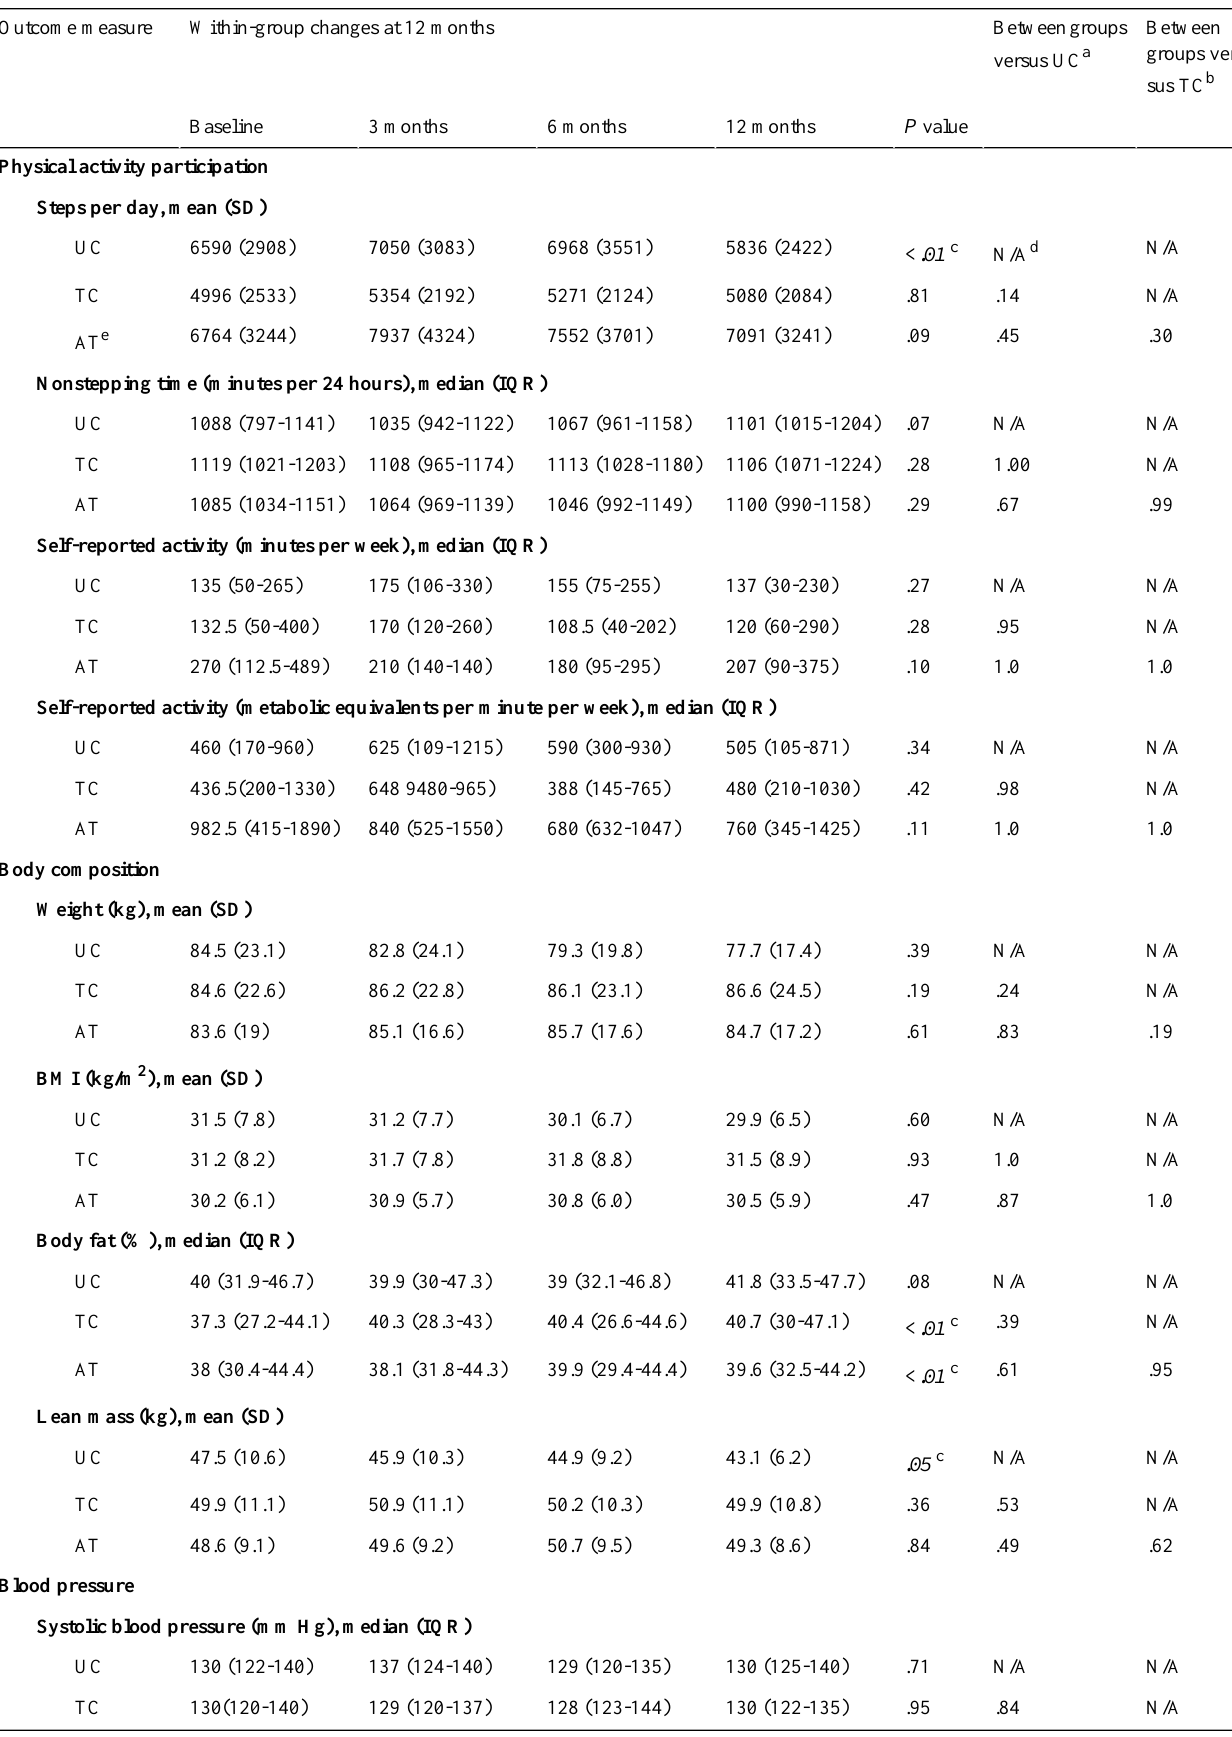
Table 2. Results of the included outcome measures at baseline and at 3, 6, and 12 months with within- and between-group P